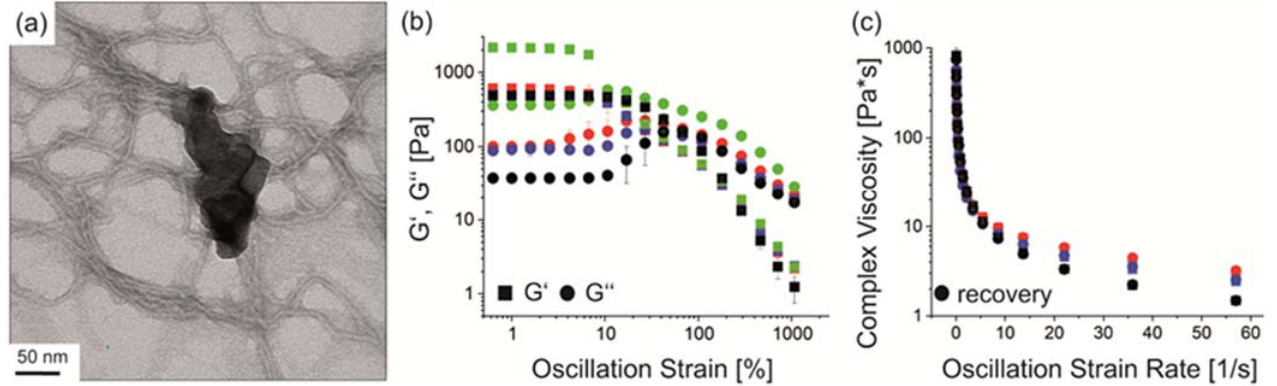
Figure 3. Fluorapatite particle (FAp) with eADF4(C16) hydrogel composites. ( a ) TEM image of eADF4(C16) fibrils and intertwined FAp particles. ( b ) Mean rheological amplitude sweep measure ‐ ments of 3% w / v eADF4(C16) (black), 3% w / v eADF4(C16) + 1% w / v FAp (red), 3% w / v eADF4(C16) + 1% w / v κ FAp (blue) and 3% w / v eADF4(C16) + 3% w / v FAp (green) composite hydrogels. ( c ) Mean rheological frequency sweep measurements of 3% w / v eADF4(C16) (black), 3% w / v eADF4(C16) + 1% w / v FAp (red) and 3% w / v eADF4(C16) + 1% w / v κ FAp (blue) composite hydrogels. κ FAp refers to FAp particles coated with eADF4( κ 16).